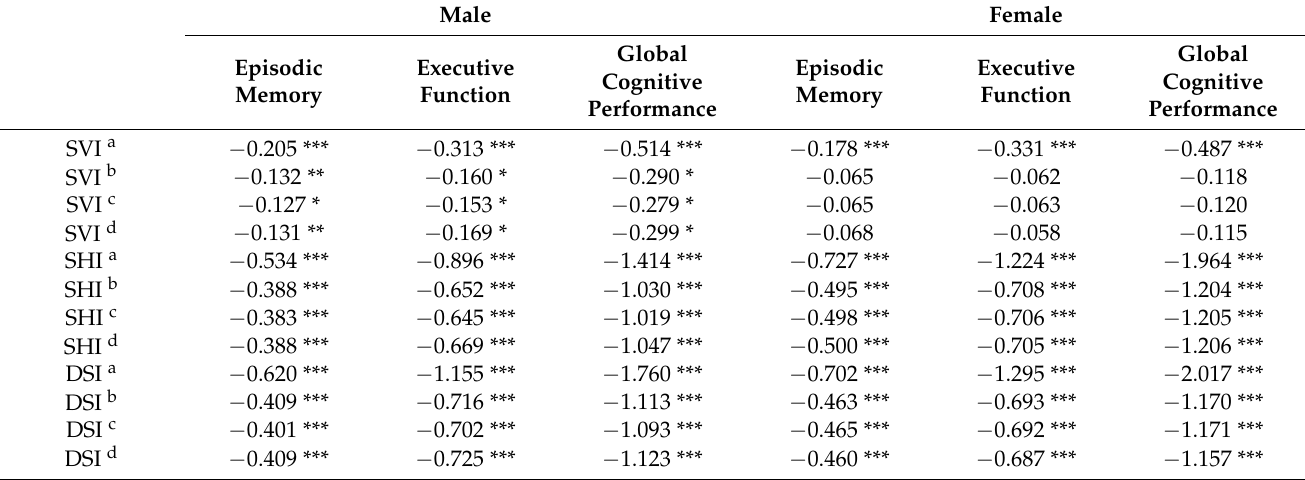
Table 4. Association between sensory impairments and cognitive decline, stratified by